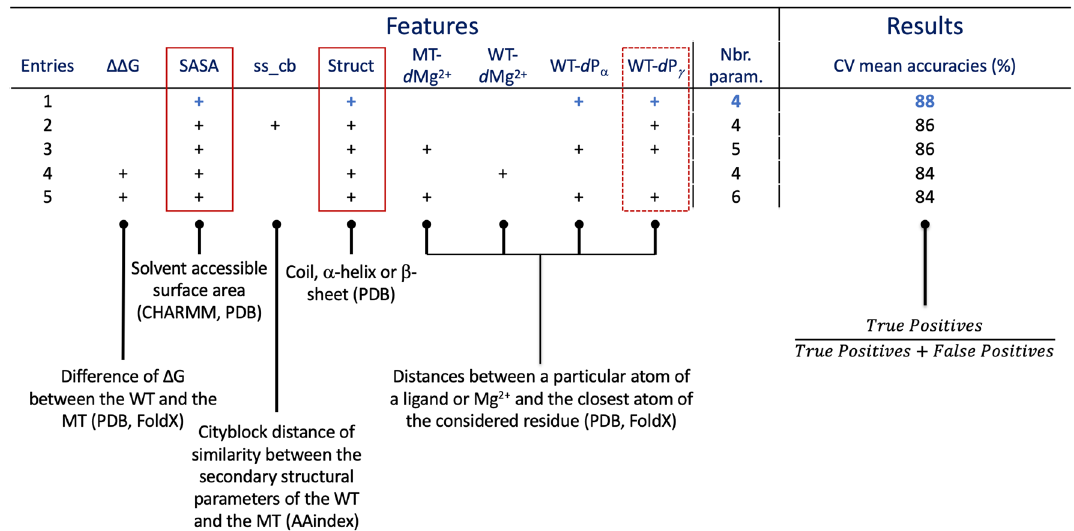
Table 1. Best predictive models. Description of the parameters used and their corresponding accuracies. The databases or tools used to build the parameters are given in brackets. The red rectangles indicate the mainly used features. WT wild-type, MT mutant, CV cross-validation.